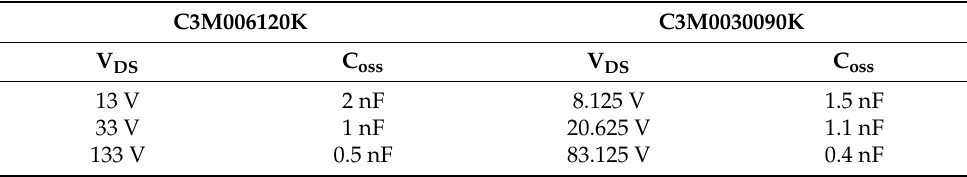
Table 1. Output parasitic capacitances according to drain–source voltage.